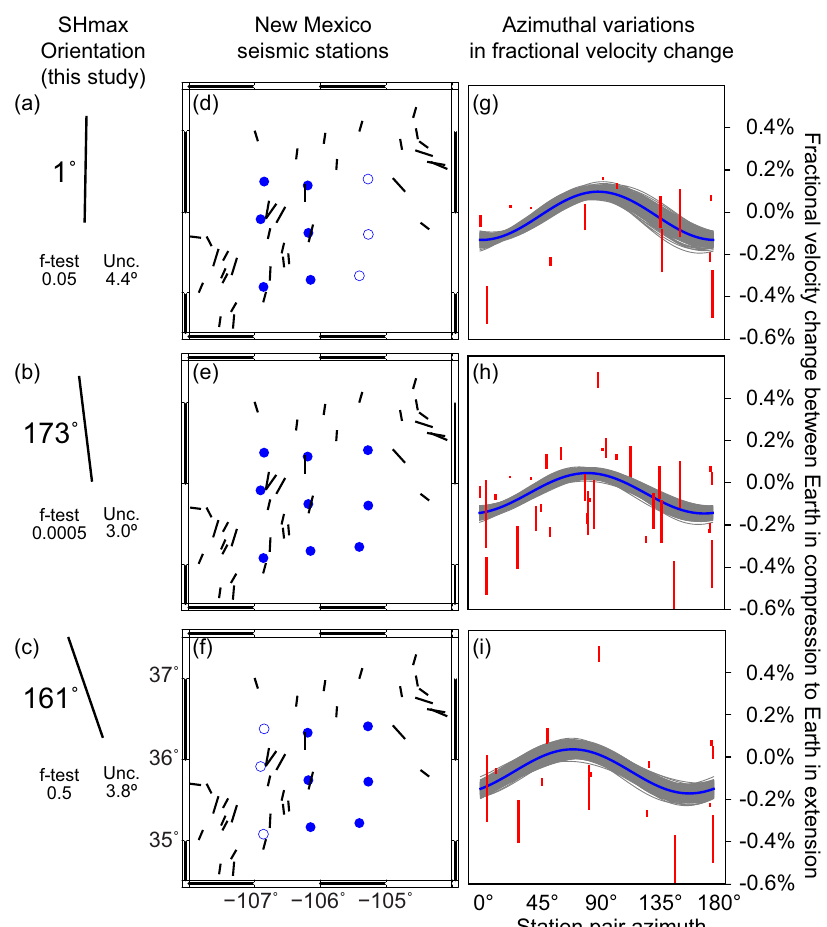
Fig. 5 New Mexico results. For New Mexico, we show the seismic stations and azimuthal dependence of the fractional change in velocity from when tidal strains were in compression with when tidal strains were in extension. a – c show the S Hmax results from this study with directional indicator, the results of an f test comparing the sine model to a uniform model, and the uncertainty in the azimuthal prediction. In d – f , the short black lines indicate the direction of S 25 using conventional methods. Classes A, B, and C are WSM quality ratings that are Hmax from the 2016 release of the World Stress Map (WSM) identi fi ed according to length. Solid blue stations are used to calculate fractional velocity changes shown adjacent g – i . Vertical red bars represent 1-sigma standard deviation uncertainties in the azimuthal measurements. The blue curve is the average of 1000 realizations (gray lines) of the best- fi t sine function applying uncertainties in azimuthal measurements. The minimum value of the blue curve indicates the orientation of S Hmax